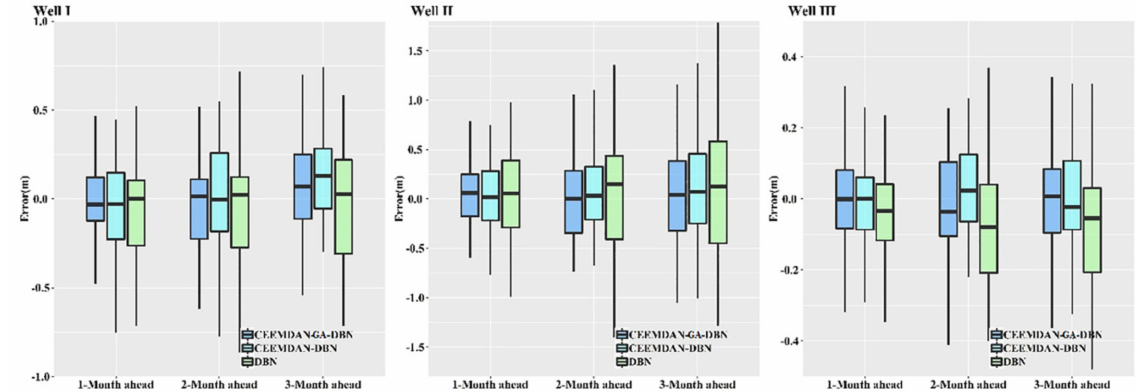
Figure 9. Boxplots of the predicted error for the 1-, 2- and 3-month ahead groundwater level forecast generated by the CEEMDAN-GA-DBN, CEEMDAN-DBN and DBN models in the testing